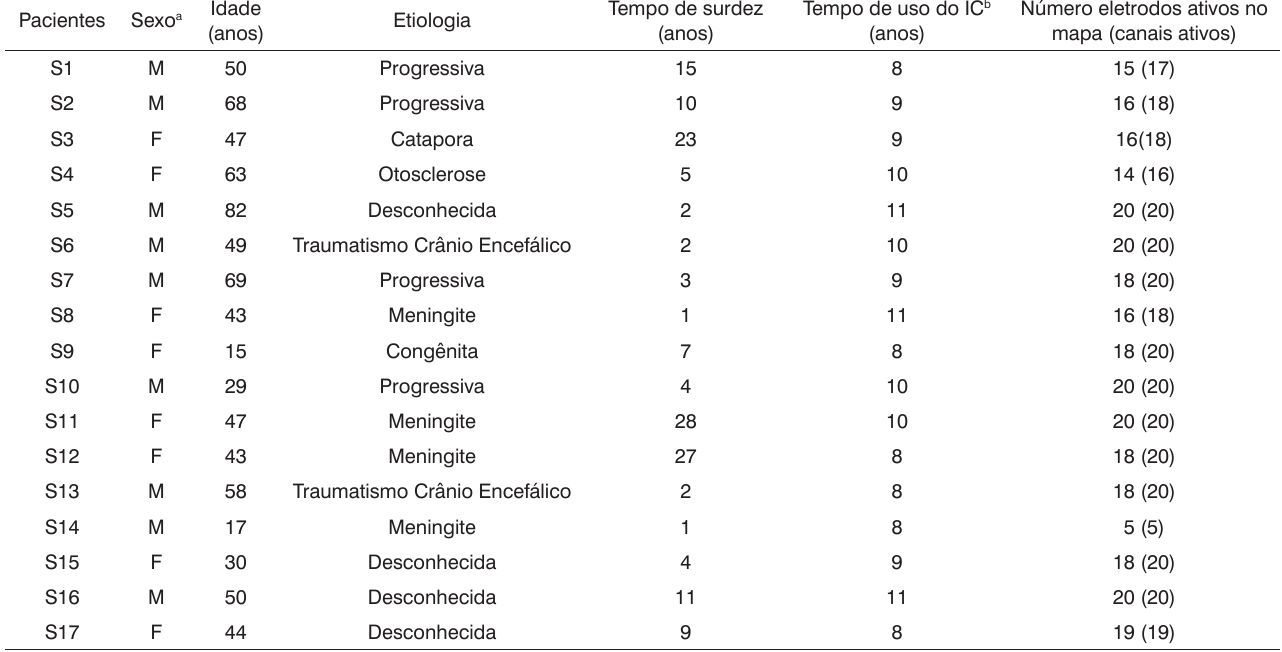
Tabela 1. Dados demográficos da